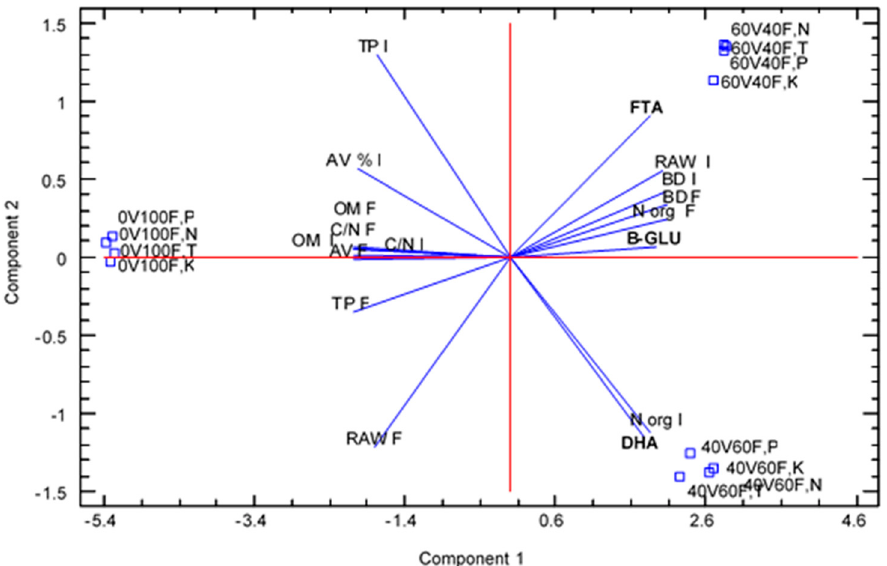
Figure 3. Principal component analysis in the melon crop. Two components were extracted with an eigenvalue > 1, which together explain 98.23% of the variability in the original data. DHA, dehydrogenase; FTA, phosphatase; β -GLU, β -glucosidase; N, Azotobacter vinelandii ; P, Bacillus megaterium ; K, Frateuria aurantia ; C, control treatment; Norg, organic nitrogen; OM, organic matter; C / N, carbon / nitrogen ratio; TP, total porosity; AVP, air volume percentage; BD, bulk density.